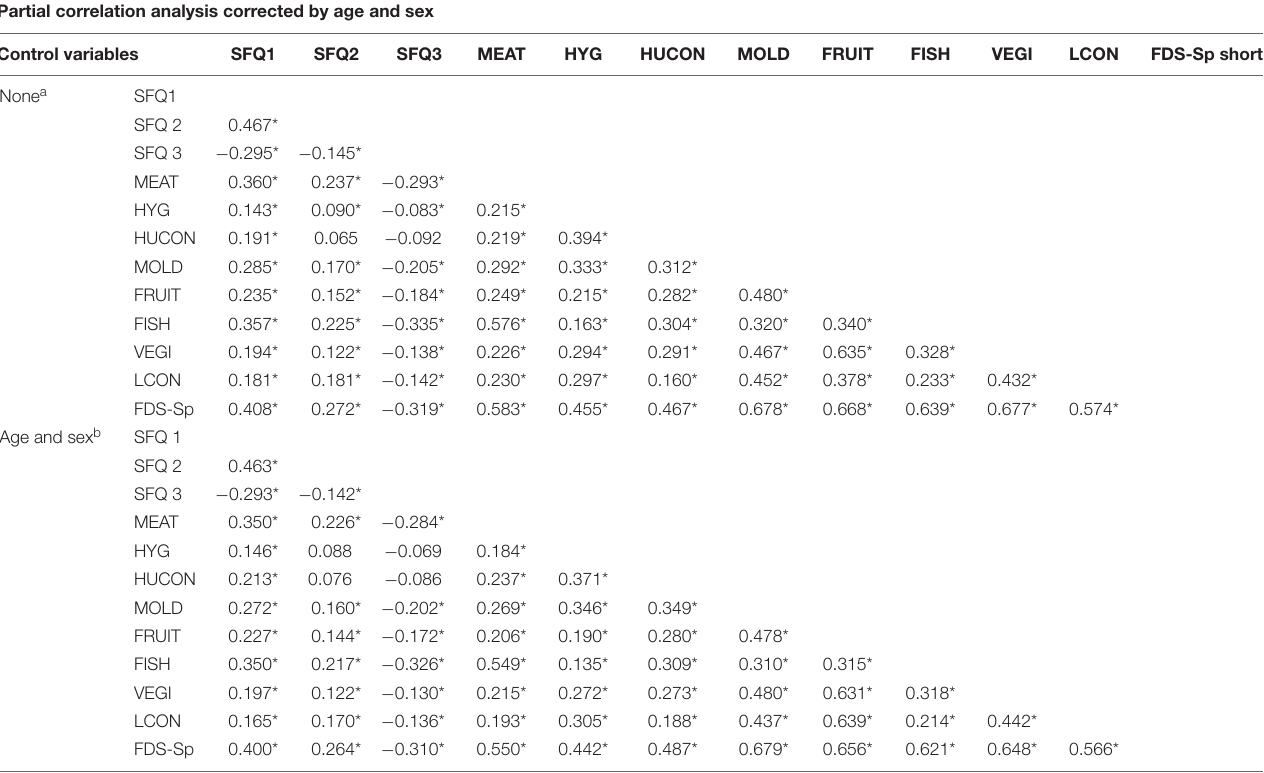
TABLE 2 | Bivariate correlations and partial correlations between picky eating items (SFQ) and FDS-Sp subscales scores controlling by sex and age ( n = 1149). Partial correlation analysis corrected by age and sex Control variables SFQ1 SFQ2 SFQ3 MEAT HYG HUCON MOLD FRUIT FISH VEGI LCON FDS-Sp short